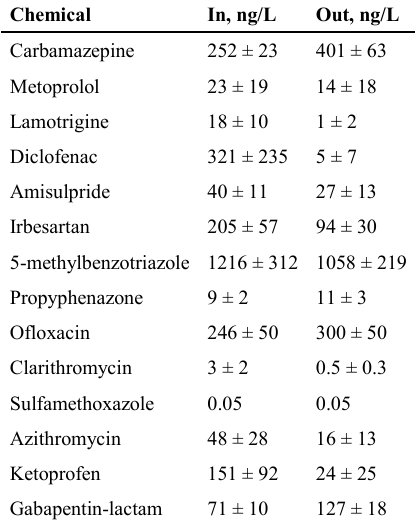
effluent samples. The presence of EMP S in the centrate derives chiefly from the residues in the activated sludge effluent, due to the only partial removal, but a contribution from the sludge release cannot be